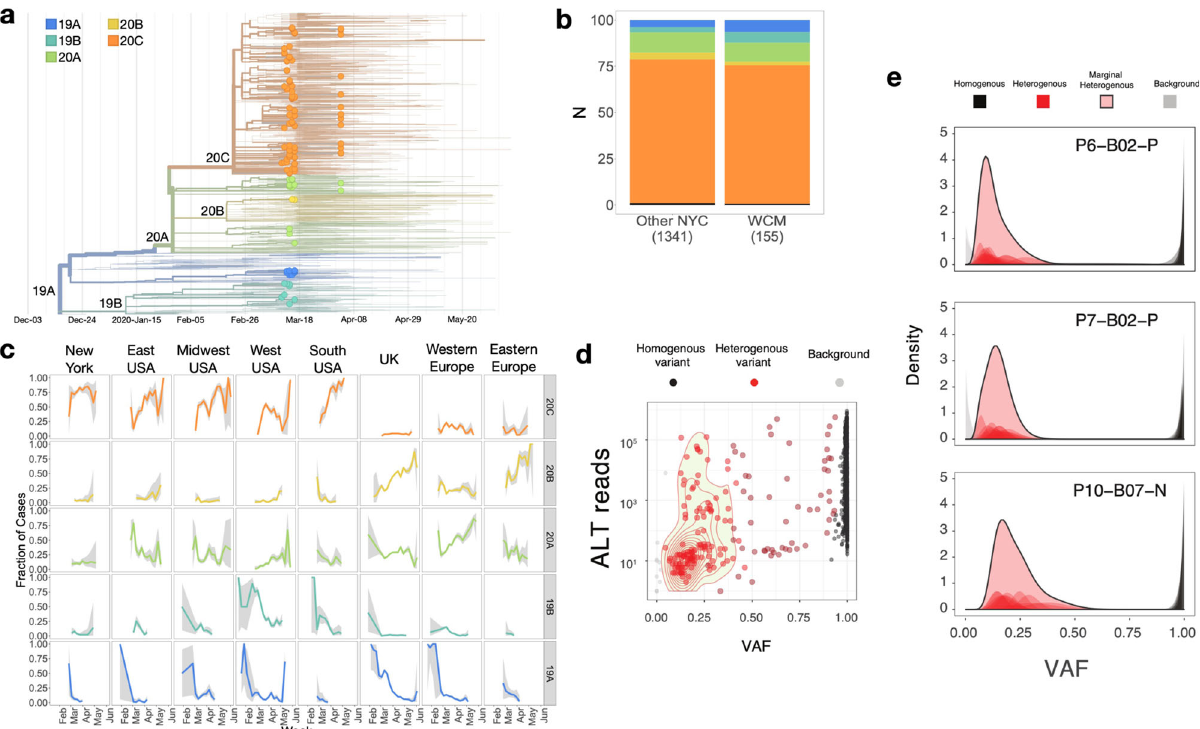
Fig. 3 Viral genome assemblies and variants. a Time-resolved phylogenetic tree of WCM samples and GISAID samples. Nodes corresponding to the 155 WCM strains are marked with circles. Branches and nodes are colored according to the Nextstrain clade af fi liation. b Clade distribution amongst WCM strains and other NY strains from GISAID. c Longitudinal distribution of clade assignments. Data points represent the portion of the sequences on GISAID matching to each clade in a given week in each of the 8 regions. Lines show the mean and gray areas around the curve represent 95% con fi dence intervals. d Variant allele frequencies (VAF, x -axis) for alternative alleles ( y -axis) were calculated for all variants across viral strains, with heterogenous (het, 5% < × < 95%, red) variants shown as well as homogenous (black) variants with VAF> 0.95. e The distribution and density of the VAF for three exemplar samples are shown relative to their variant type